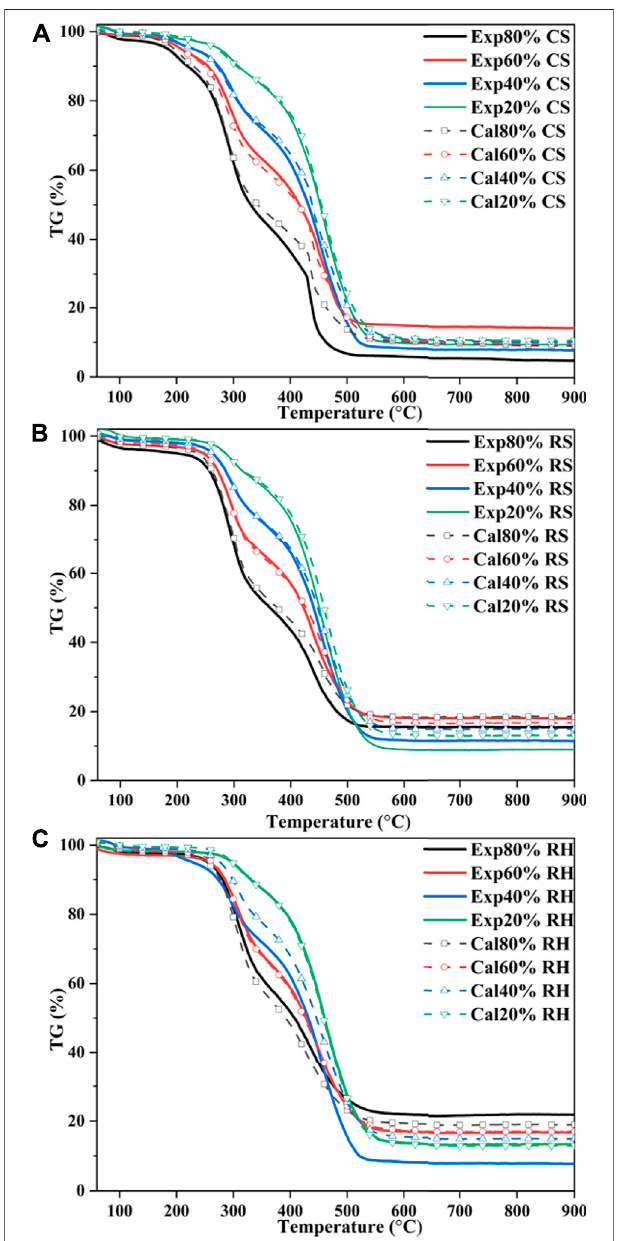
FIGURE 5 | Comparison of calculated and experimental TG values: (A) CS, (B) RS, and (C) RH.